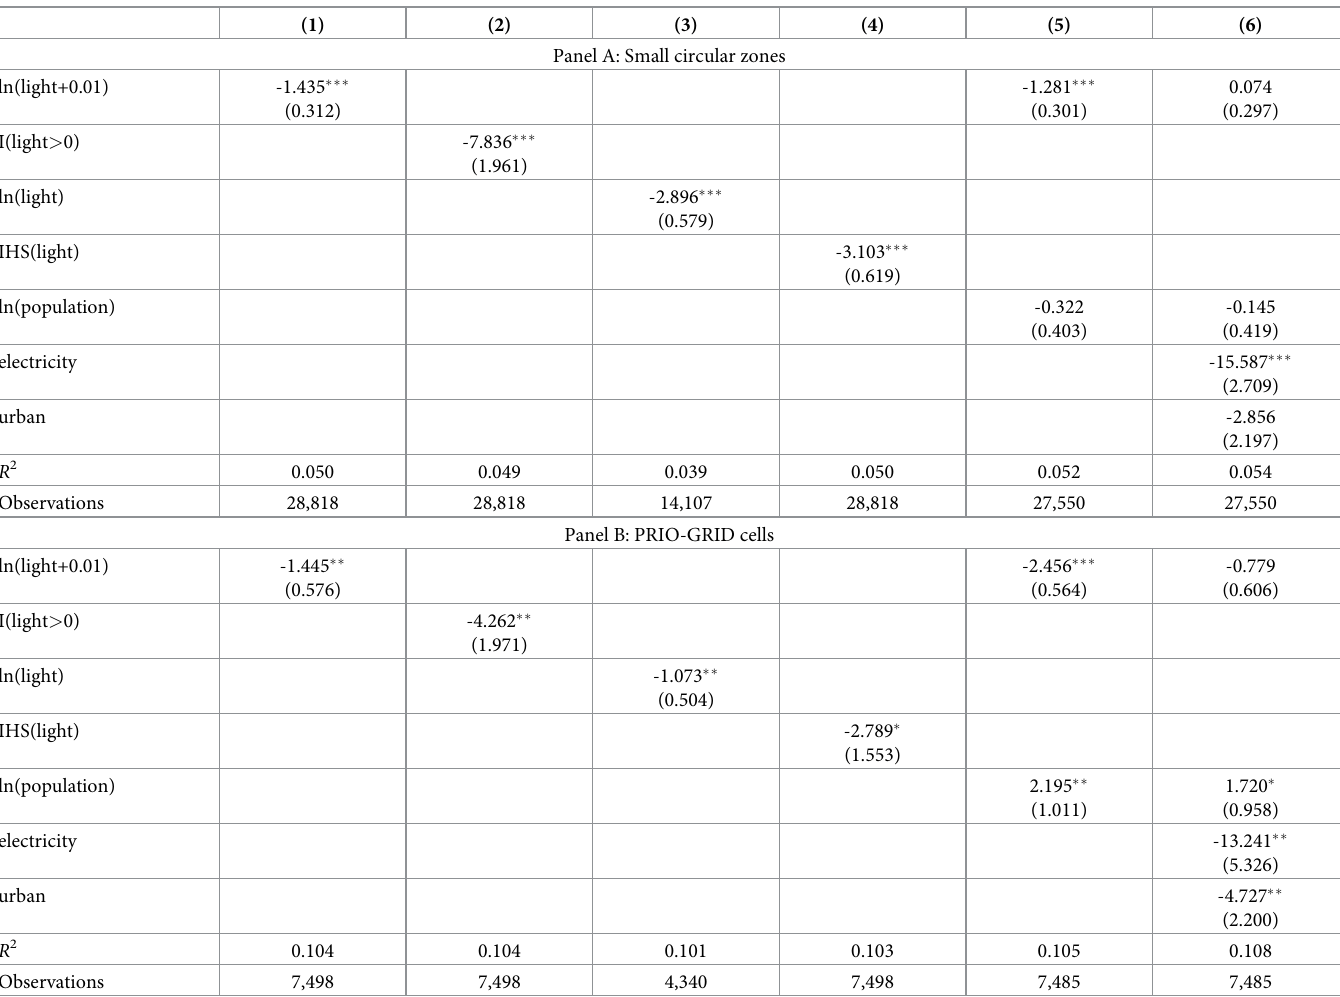
Table 6. Nighttime lights and infant